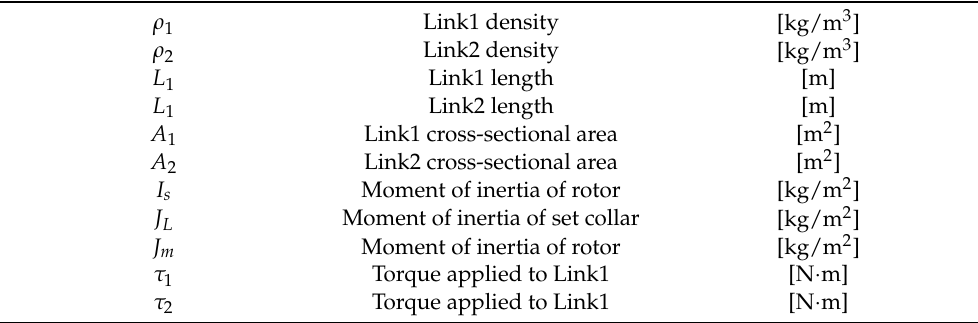
Table 1. Parameters of each